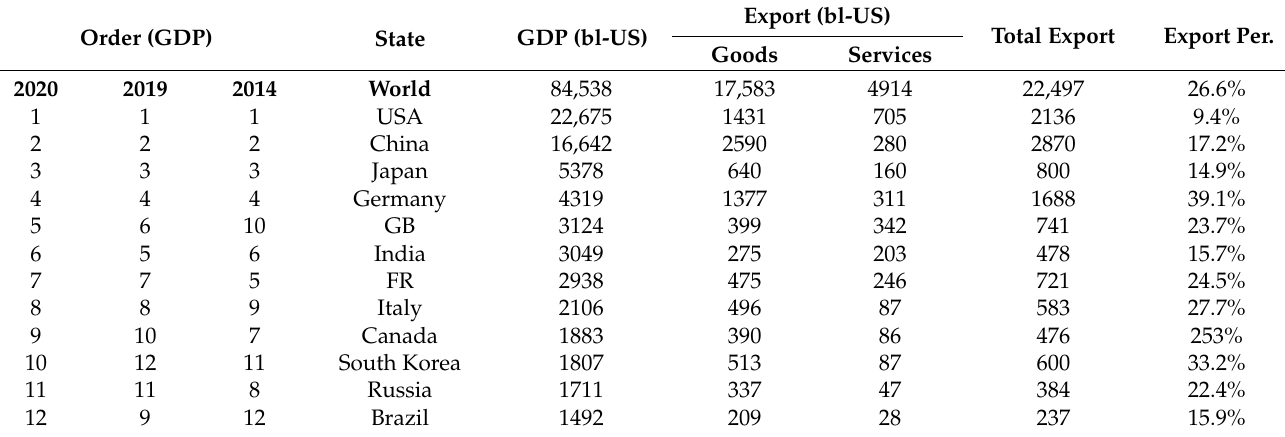
Table 1. Export performance of companies from the largest economies in 2019 (%). Source: Authors’